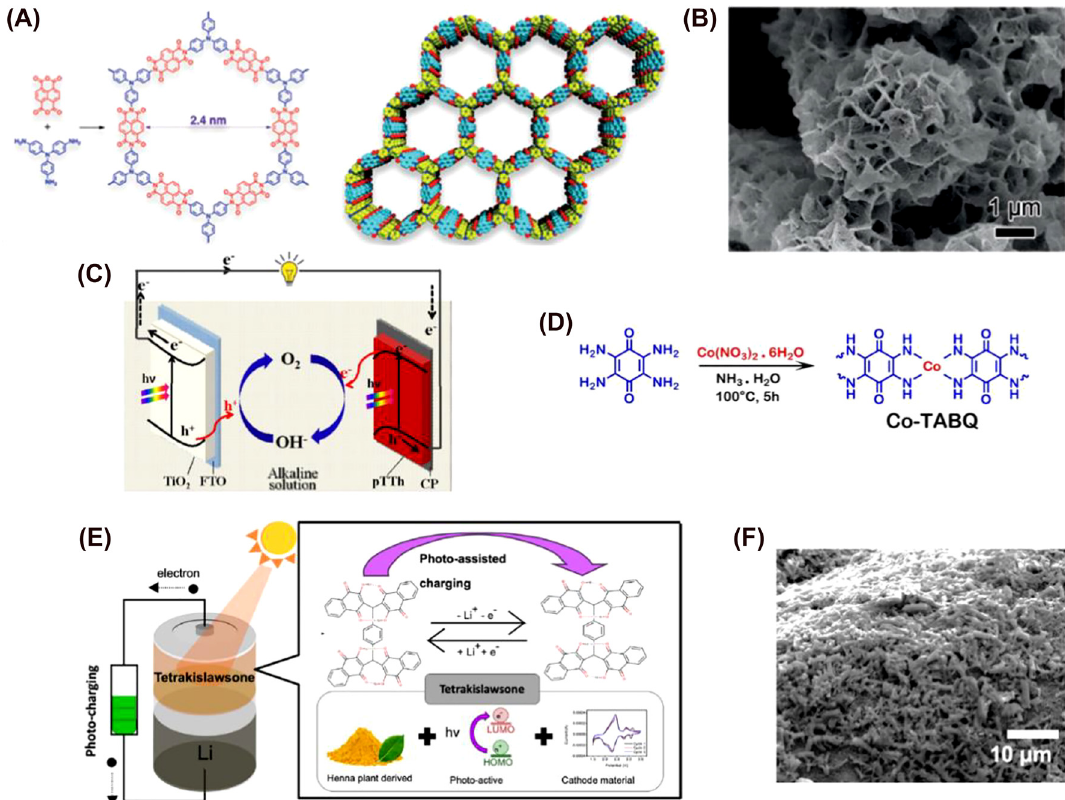
Figure 10: Organic-based photoelectrodes. (A) Condensation reaction and extended structure of NT-COF showing hexagonal mesoporous channels with the alternating columns of